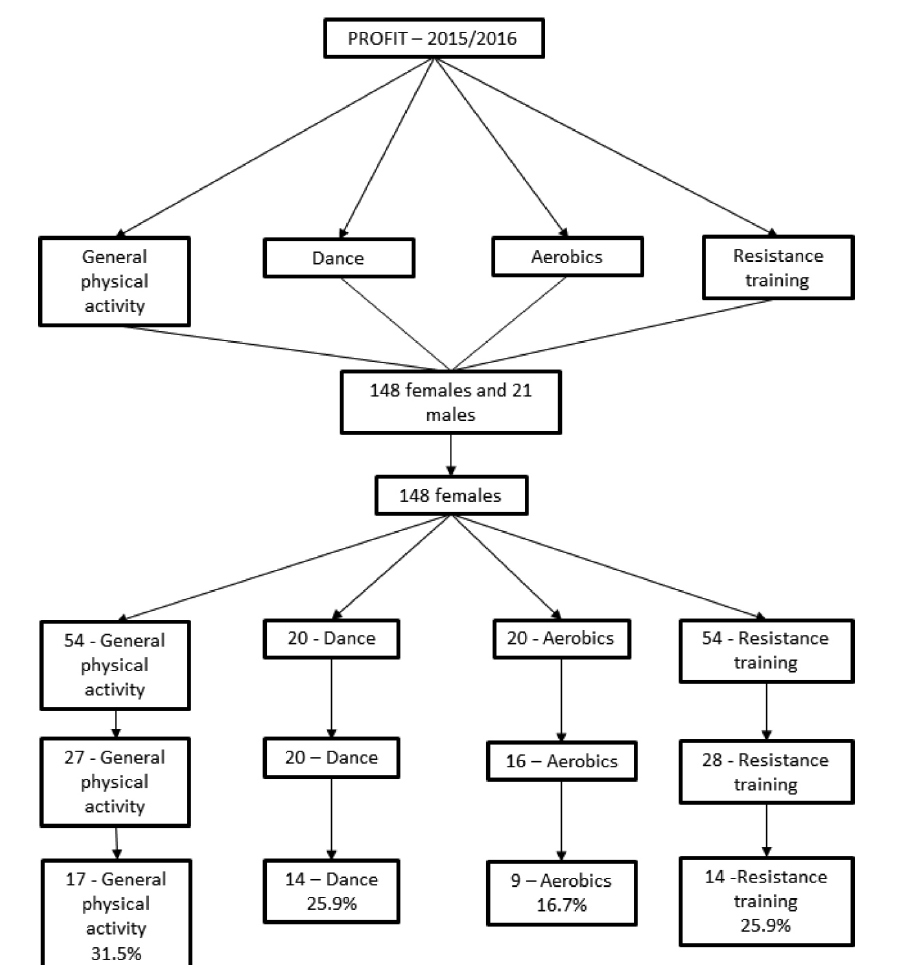
Figure 1. Flow diagram for sample